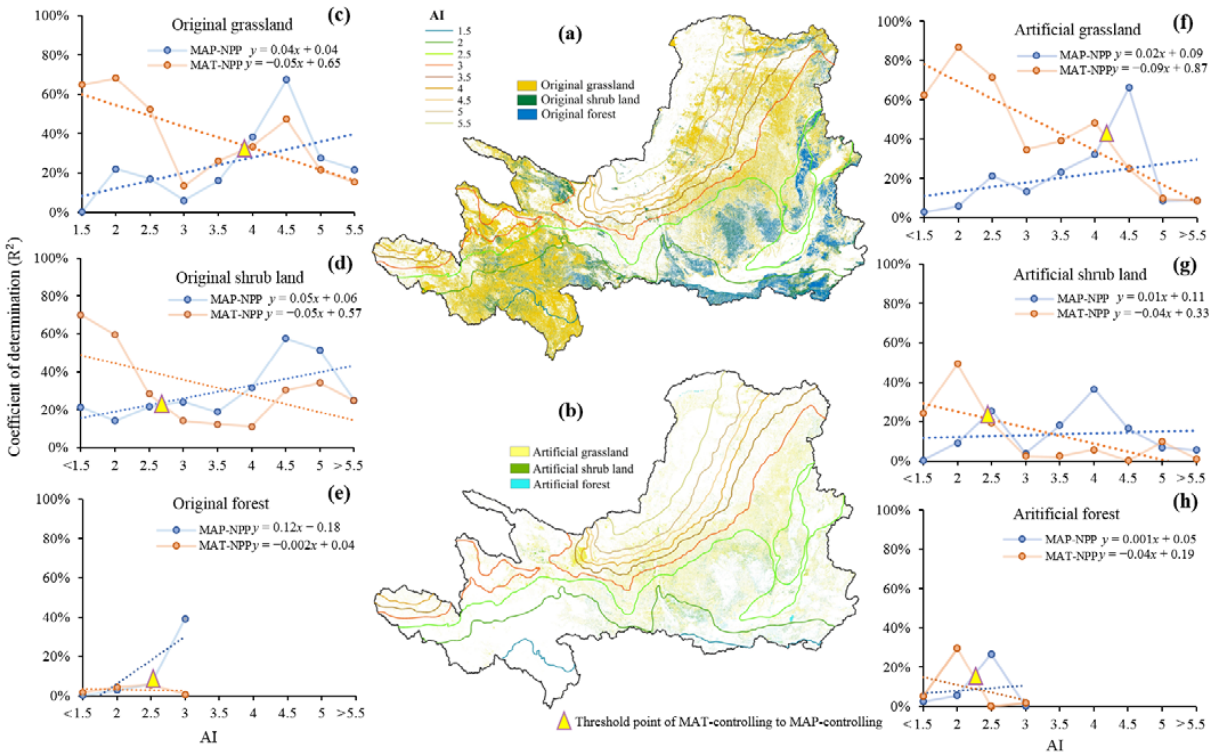
Figure 7. AI gradients with ( a ) original vegetation distribution and ( b ) artificial vegetation distribu- tion, and correlation coefficient of determination (R 2 ) among MAT, MAP, and NPP along AI gradients in ( c ) original grassland, ( d ) original shrub land, ( e ) original forest, ( f ) artificial grassland, ( g ) artificial shrub land, and ( h ) artificial forest.